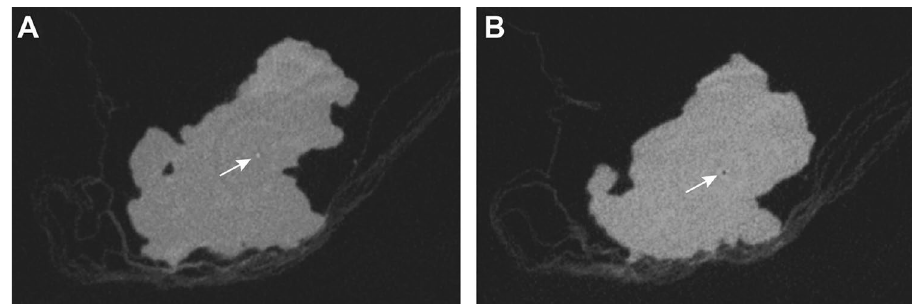
Figure 4. Artifacts in CBCT images of specimens were usually artifacts of the central axis that typically appeared as a central hyperdense spot in some slices ( A ) and a central hypodense spot in other slices ( B ) or ring artifacts ( A and B